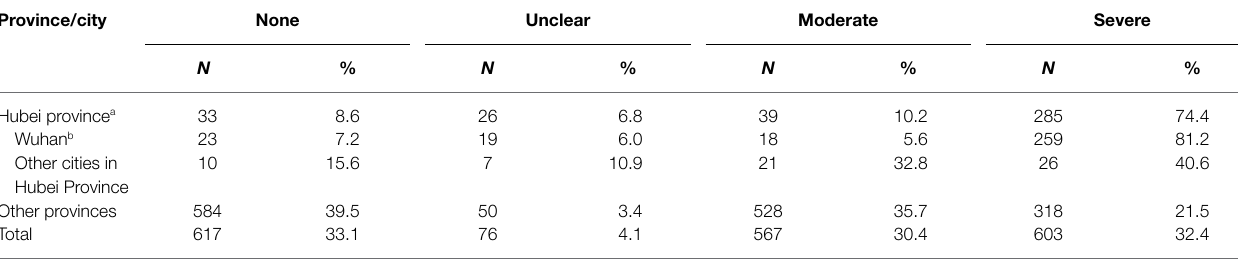
TABLE 2 | Participants’ perceived risk of Coronavirus 2019 (COVID-19) infection, by geographic area.